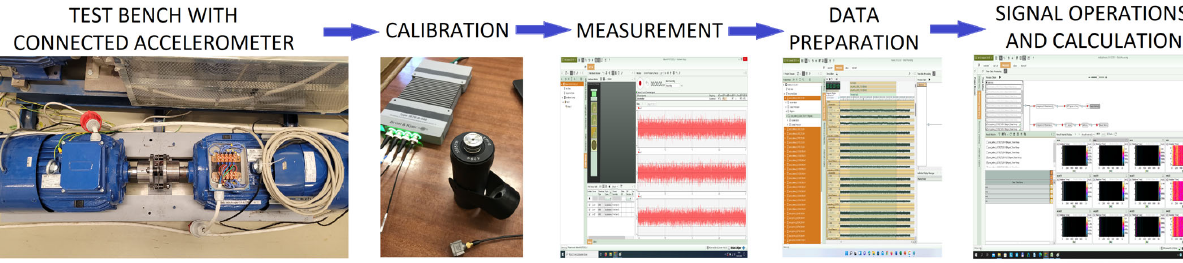
Figure 4. Flowchart of the vibration measurement.